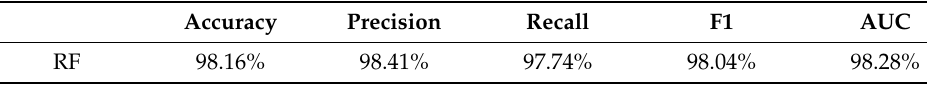
Table 8. Detection results of cracked duck